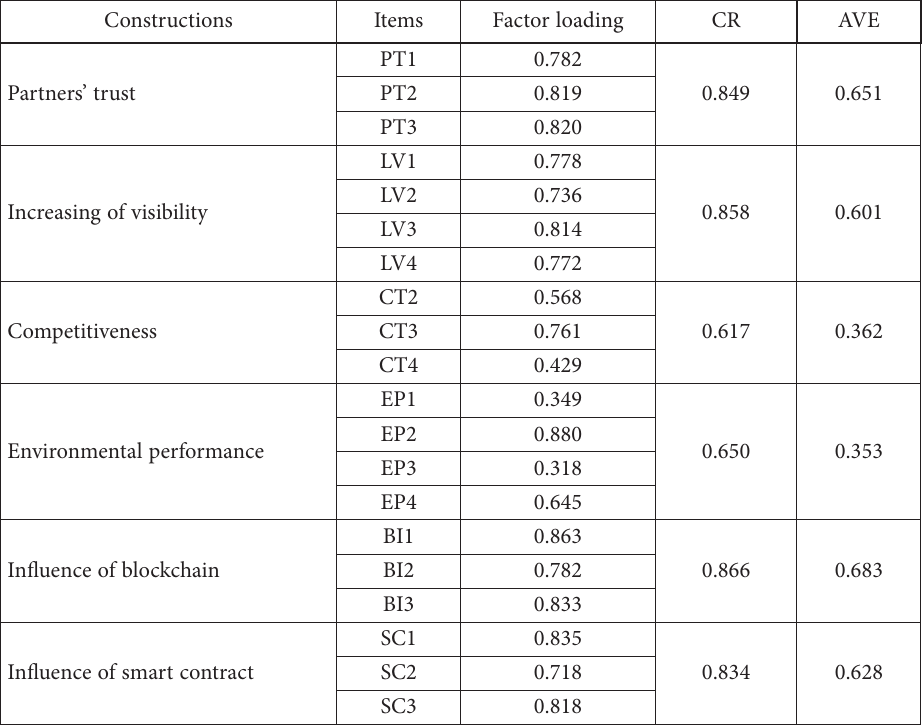
Table 3. Test results of construction validity and